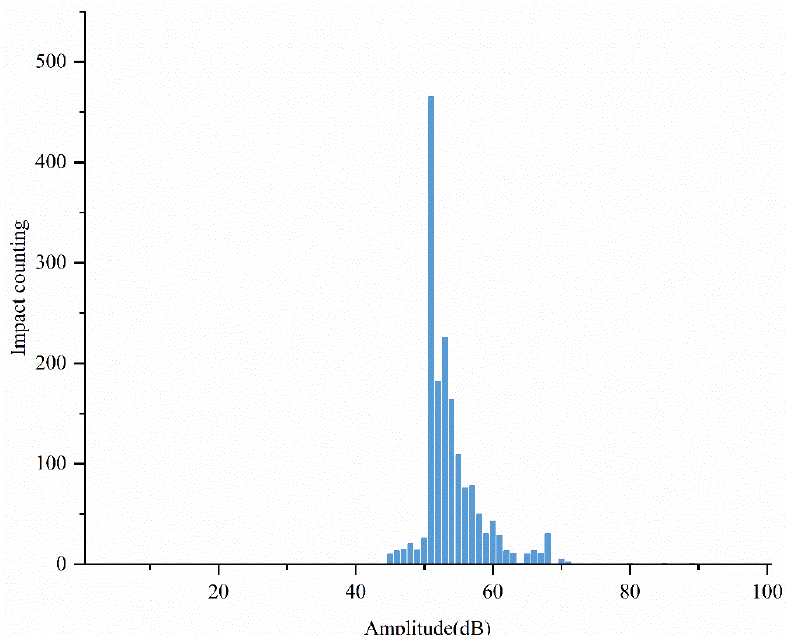
Figure 10. Impact-amplitude correlation diagram of cable noise signal of Caihong Bridge.